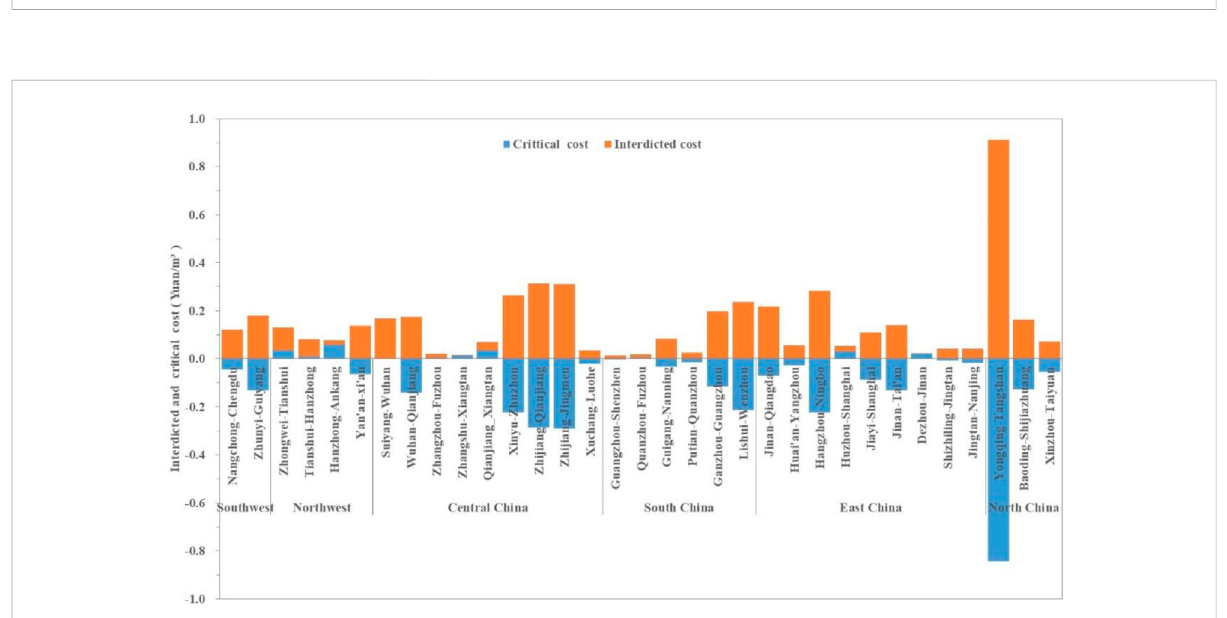
FIGURE 3 Spatial distribution of nodal prices and pipeline congestion in gas network (the pipeline congestion is expressed by the ratio of fl ow to capacity (A) the fl ow distribution in exiting natural gas network by TP model (B) the optimal fl ow distribution in existing natural gas network by MEPC model.